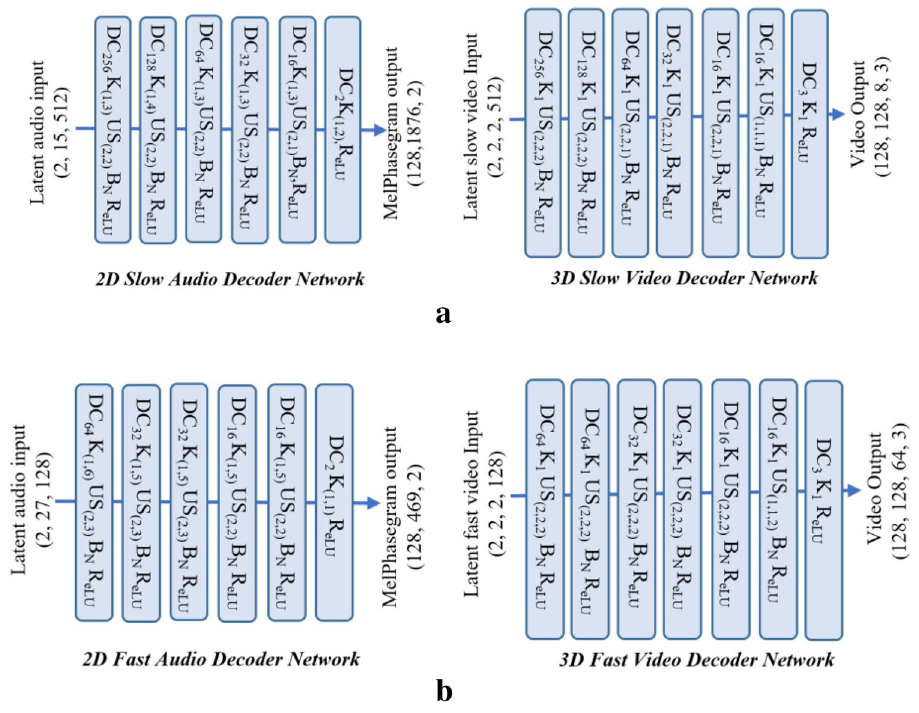
Figure 8. ( a ) The slow branch of the separable slow–fast decoder network. ( b ) The fast branch of the separable slow–fast decoder network.